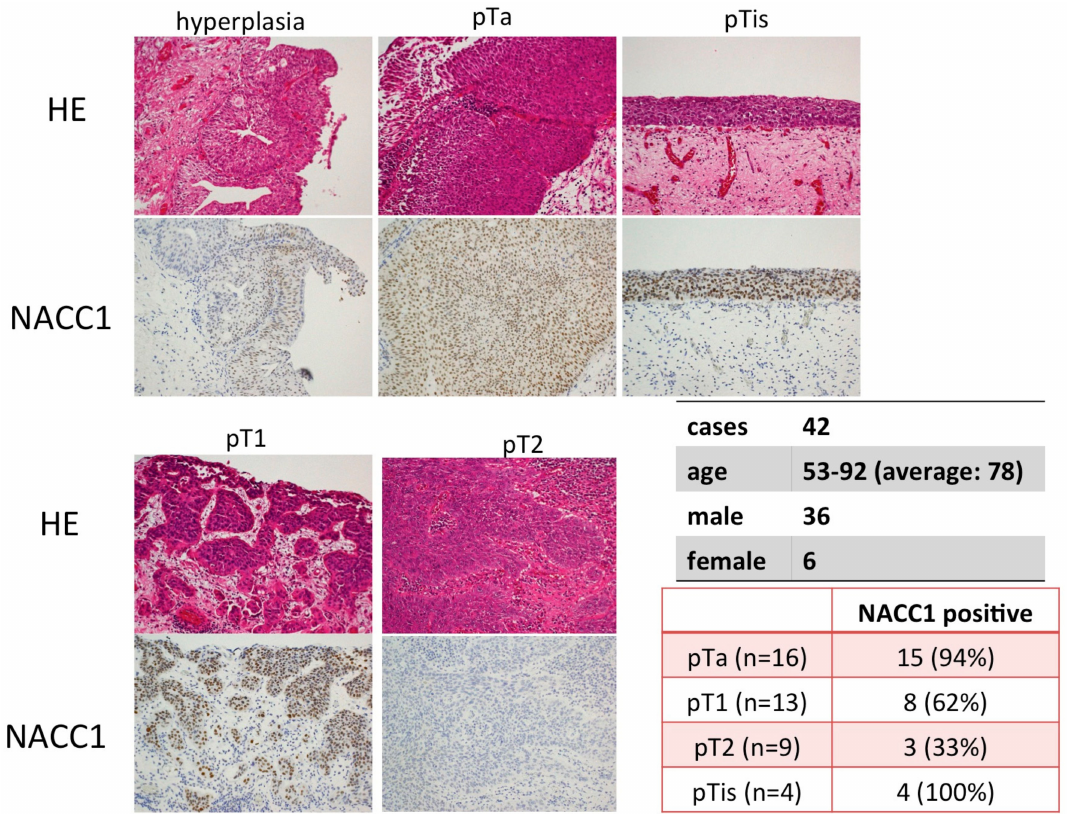
Figure 1. Expression of Nucleus accumbens-associated protein 1(NACC1) in Urothelial carcinoma (UC) of bladder tissues. UC were histologically classified in pTa, pTis, pT1 and >pT2. Hematoxylin and eosin (HE) stain and Immunohistochemistory,scale bar: ×